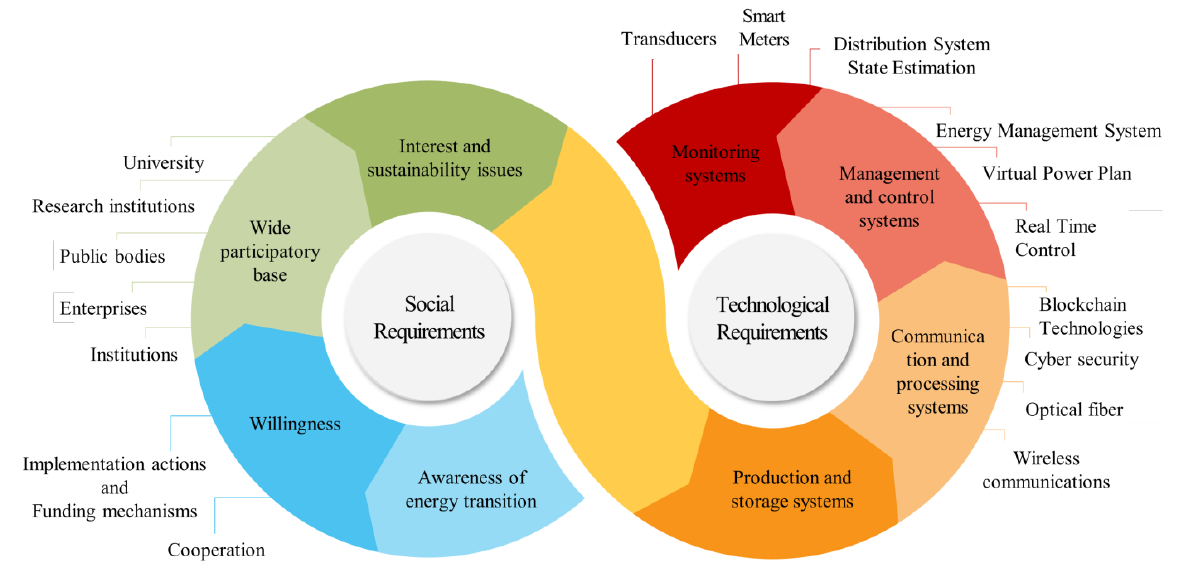
Figure 3. Social and technological